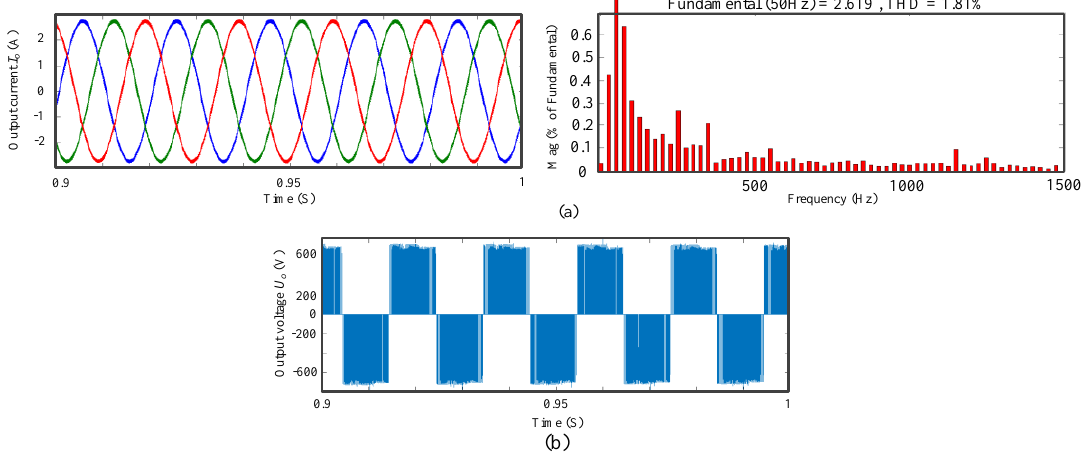
Figure 12. Output current and voltage with distorted supply under rated condition ( a ) output current and its THD; ( b ) output voltage.